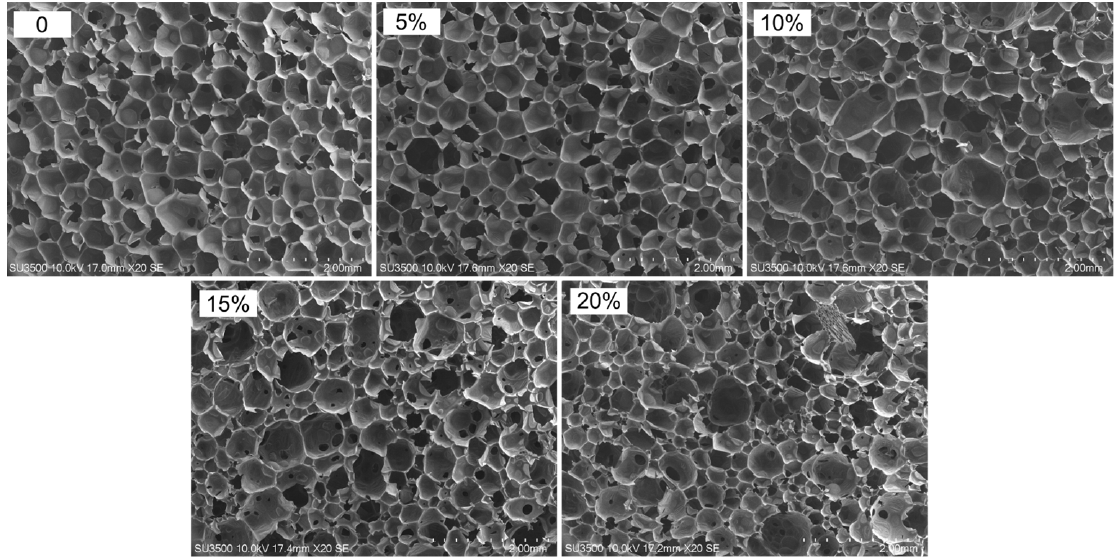
Figure 2. SEM images of PUR foam with different amounts of wood filler.